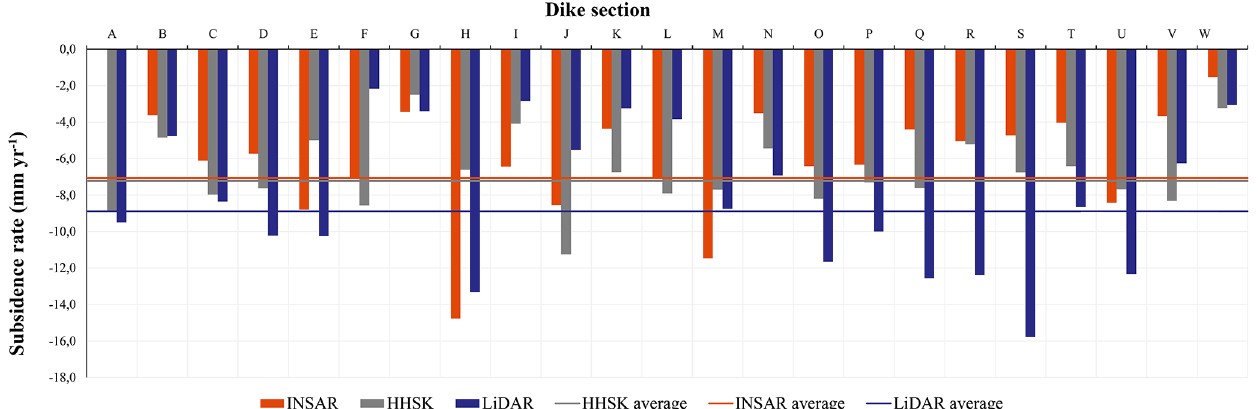
Figure 6. Comparison of subsidence rate for every dike section as determined with the three different datasets.